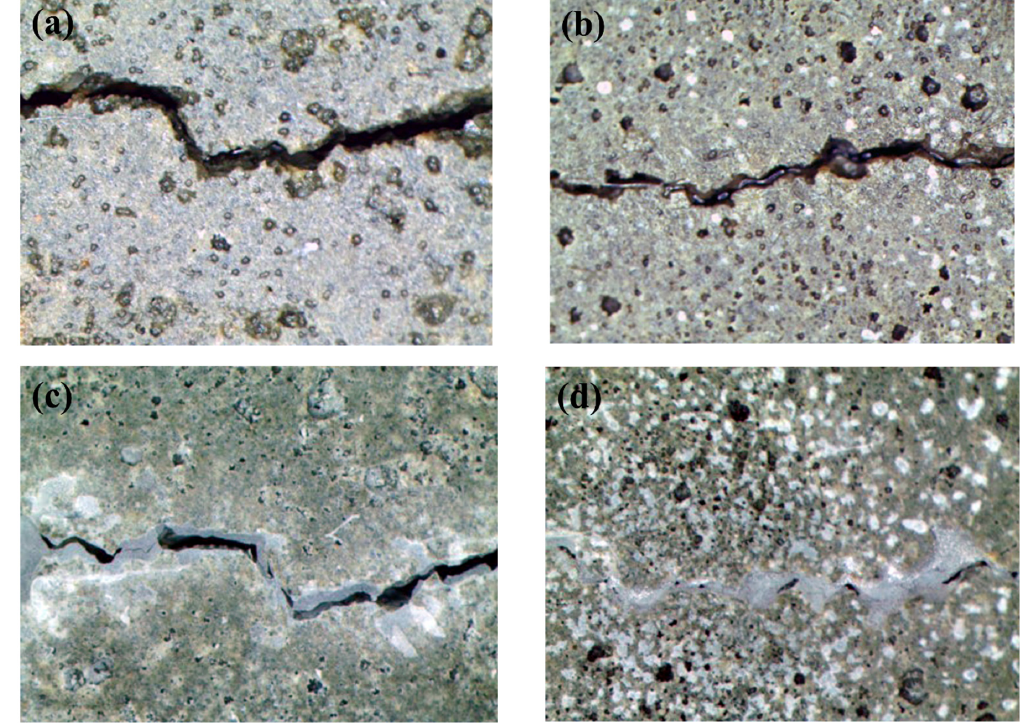
Figure 12. Visual crack closure ( a ) BM at day 0, ( b ) BPM at day 0, ( c ) BM at day 28 and ( d ) BPM at day 28